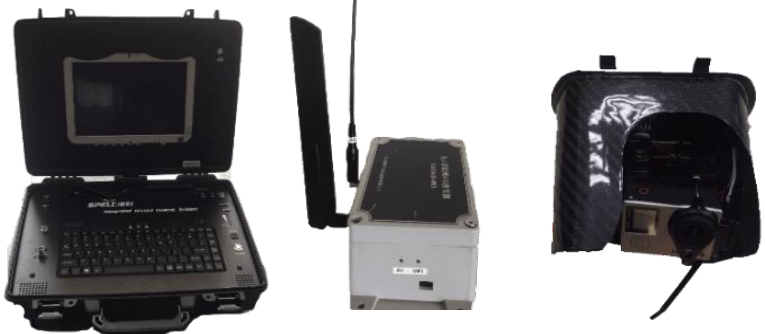
Figure 1. The ground control system, onboard Automatic Identification System (AIS) transceiver and imagery device.